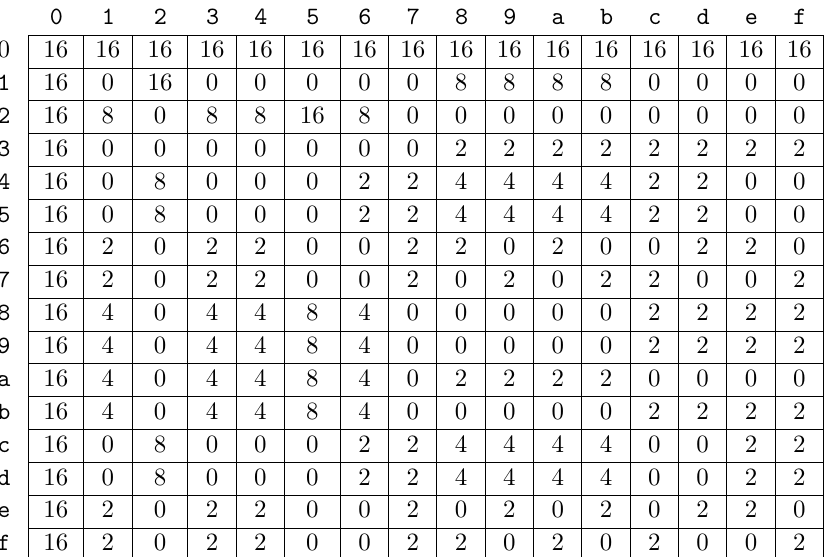
Table 3: BCT of SKINNY ’s 4-bit